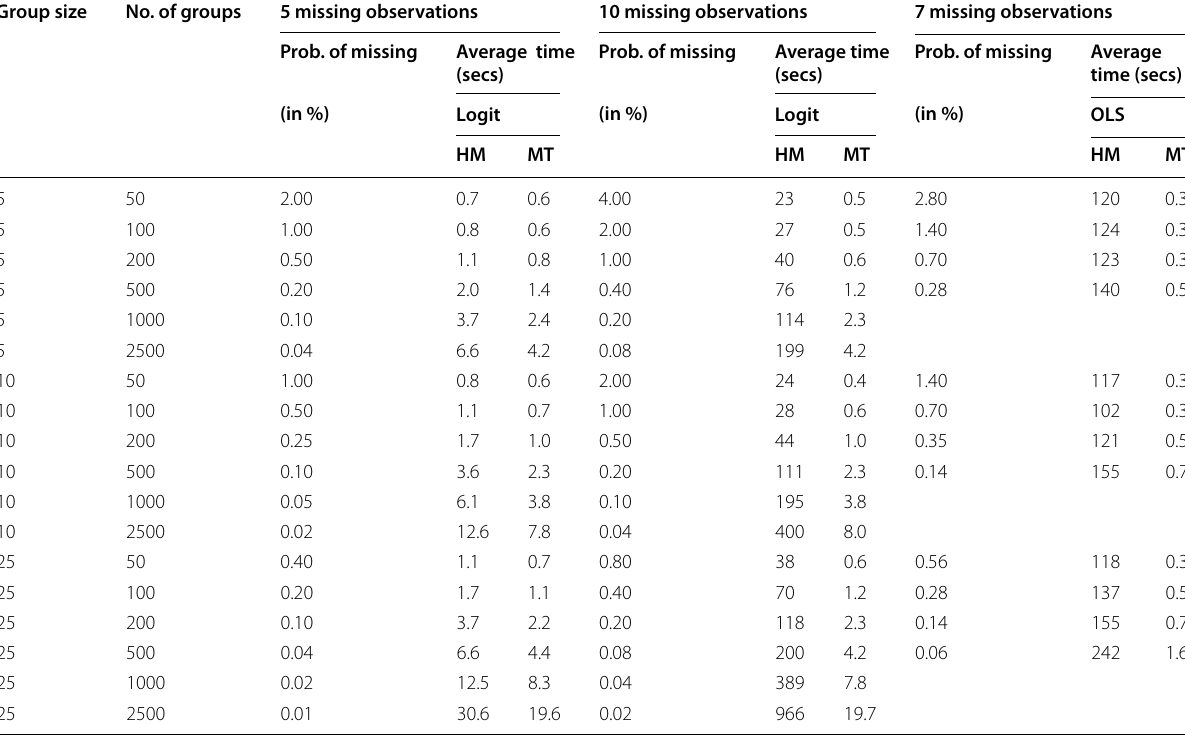
Table 4 Time performance of the Horowitz–Manski (HM) and Manski–Tamer (MT) interval estimators (with non-closed groups and individuals excluded from their own peer